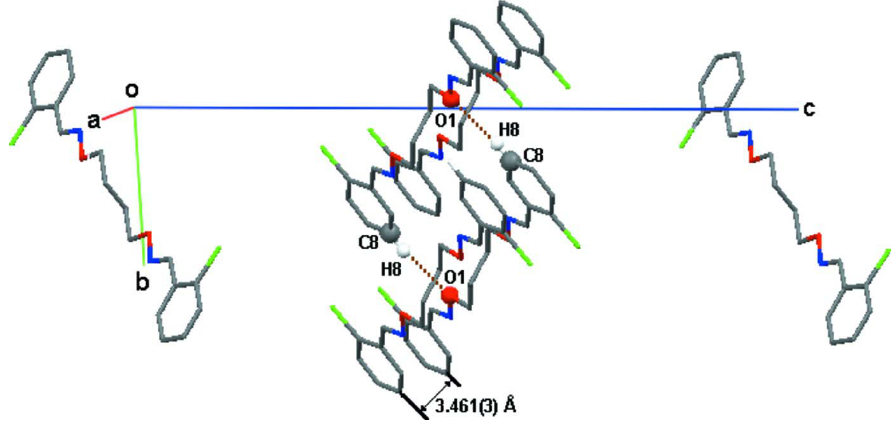
The molecular structure of the title compound with atom numbering scheme [Symmetry codes: - x , - y + 2, - z + 1]. Displacement ellipsoids for non-hydrogen atoms are drawn at the 30% probability level.